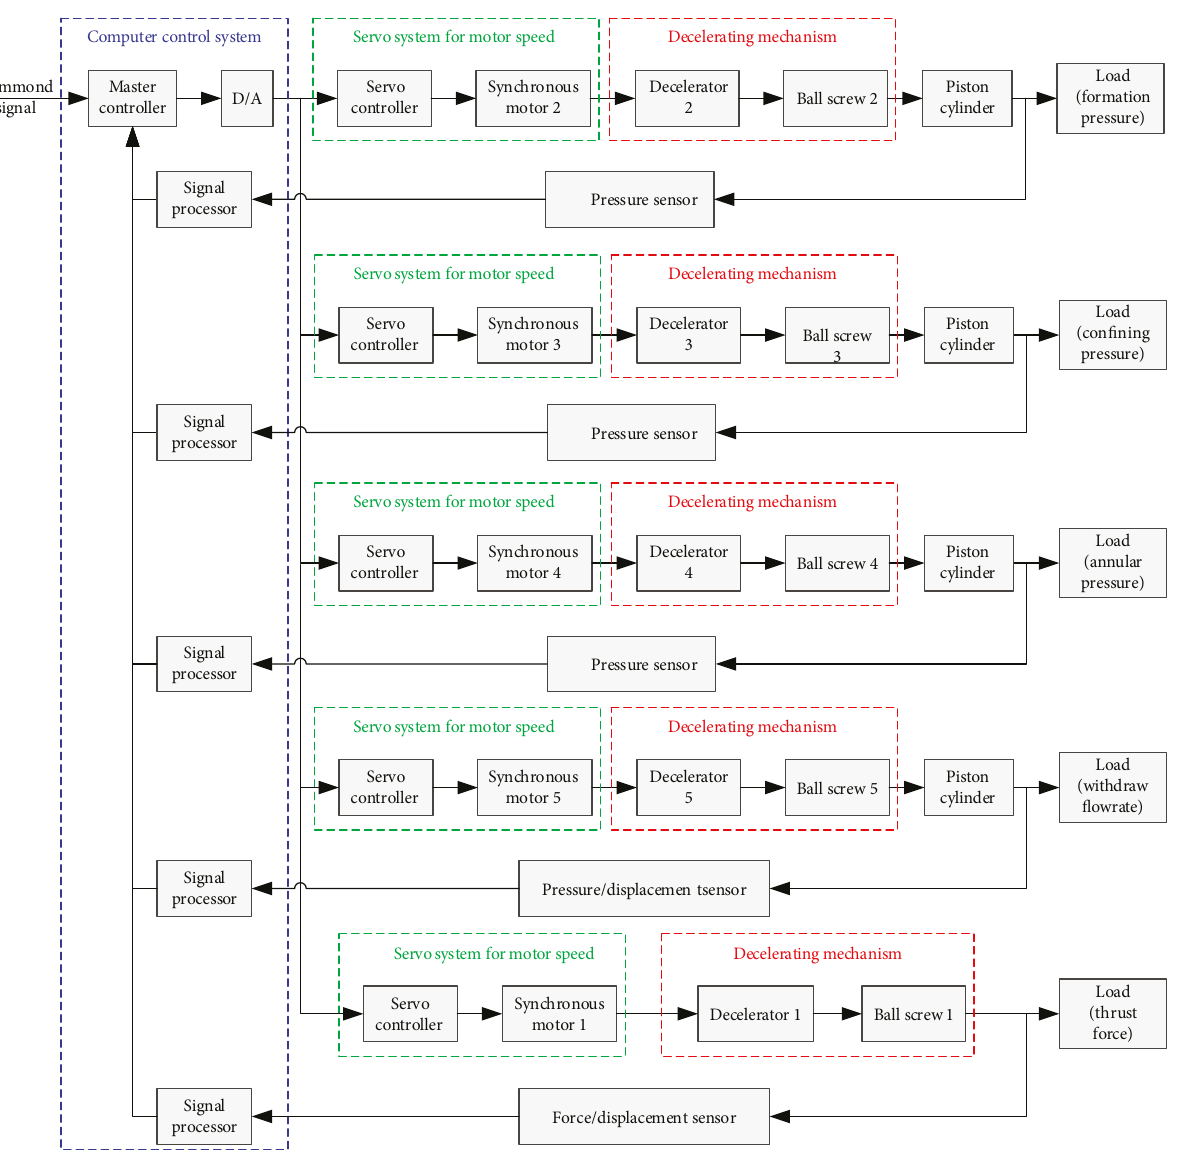
Figure 8: Scheme of the control